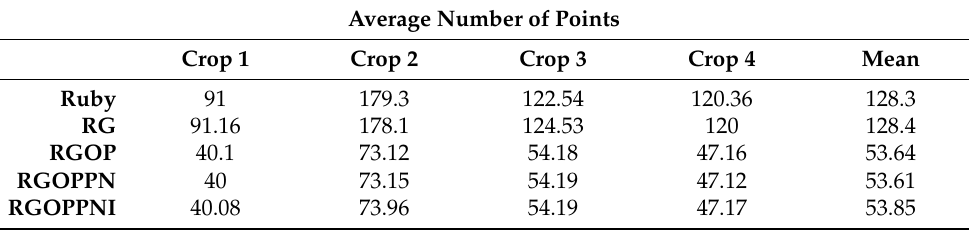
Table 5. The average number of points considered by the line finding algorithms during the 500 first iterations of each run.